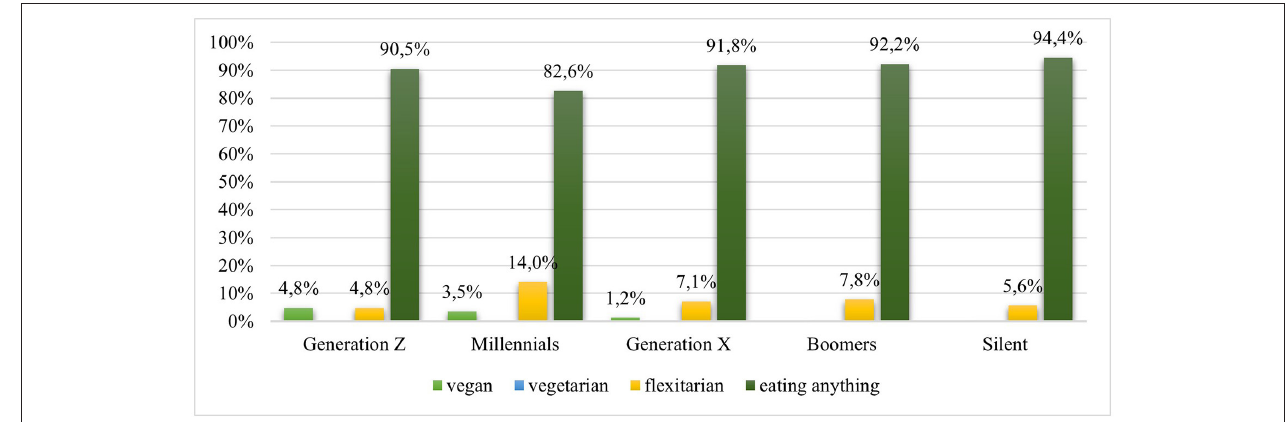
FIGURE 2 | Respondent eating habits according to age generations. Source: own processing and data